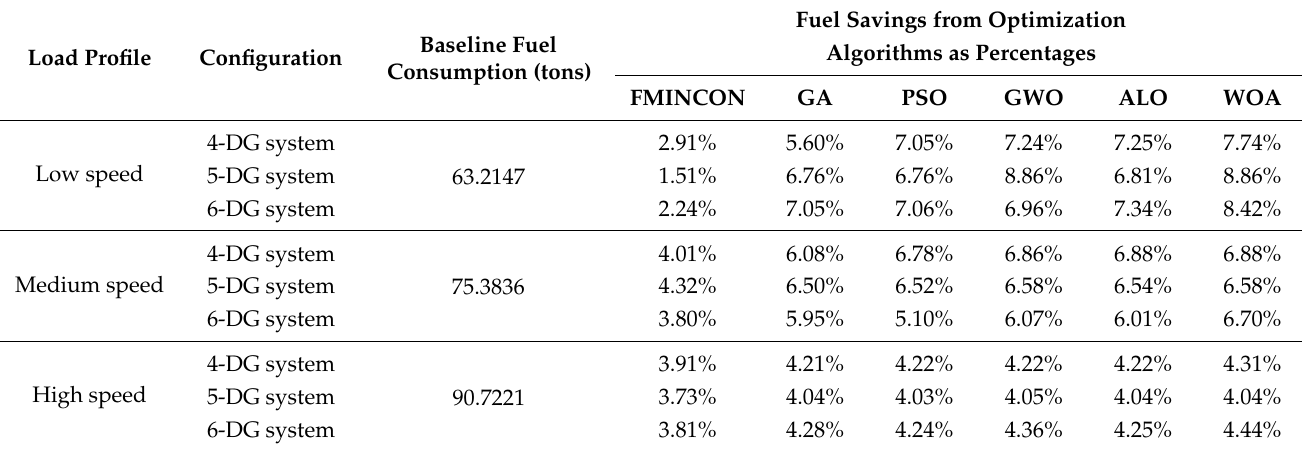
Table 2. Average fuel-saving results of all algorithms.